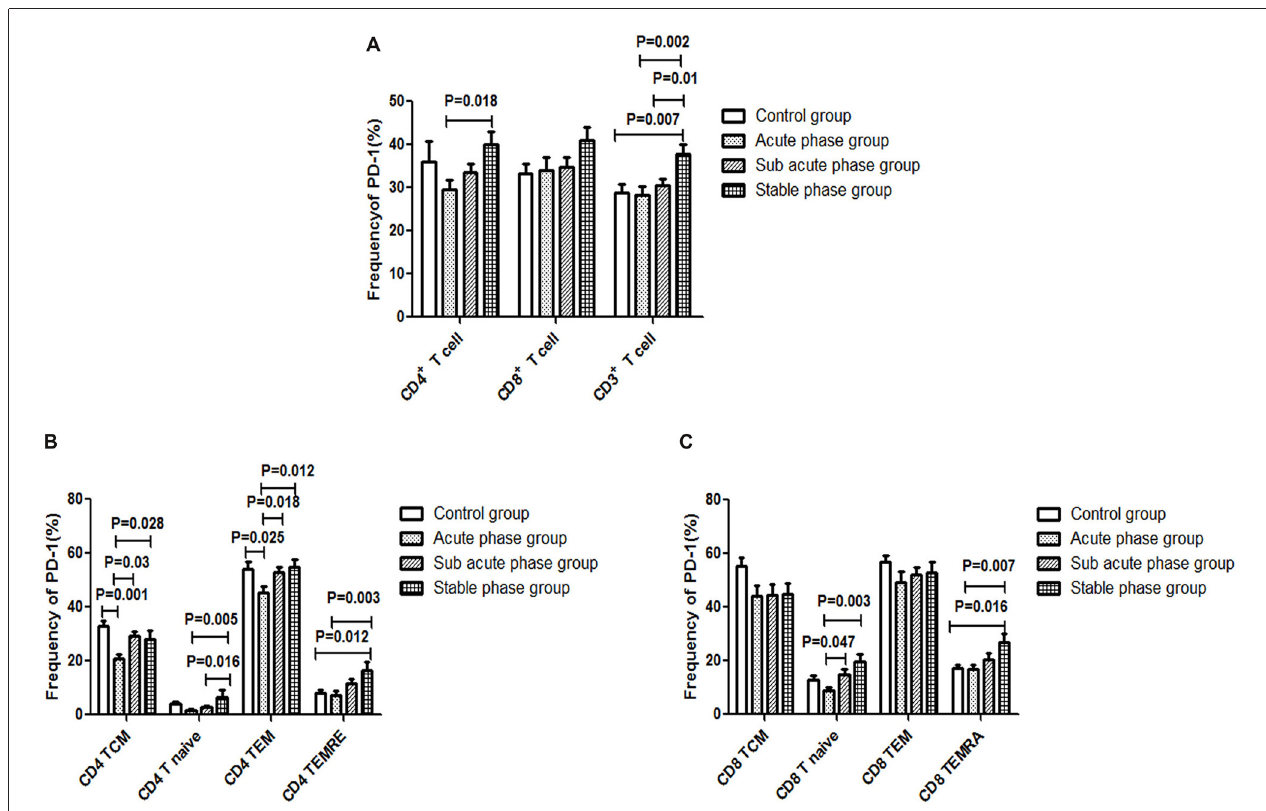
FIGURE 6 | (A) Programed cell death-1 (PD-1) expression in T cells in the ischemic stroke (IS) groups and the control group. (B) PD-1 expression in CD4 + T cells in the IS groups and the control group. (C) PD-1 expression in CD8 + T cells in the IS groups and the control group (comparisons between groups were performed via one-way ANOVA, and a post hoc test was used to determine differences between groups. Graphs show the mean + SEM; Control group ( n = 14), Acute phase group ( n = 18), Sub-acute phase group ( n = 31), Stable phase group ( n =